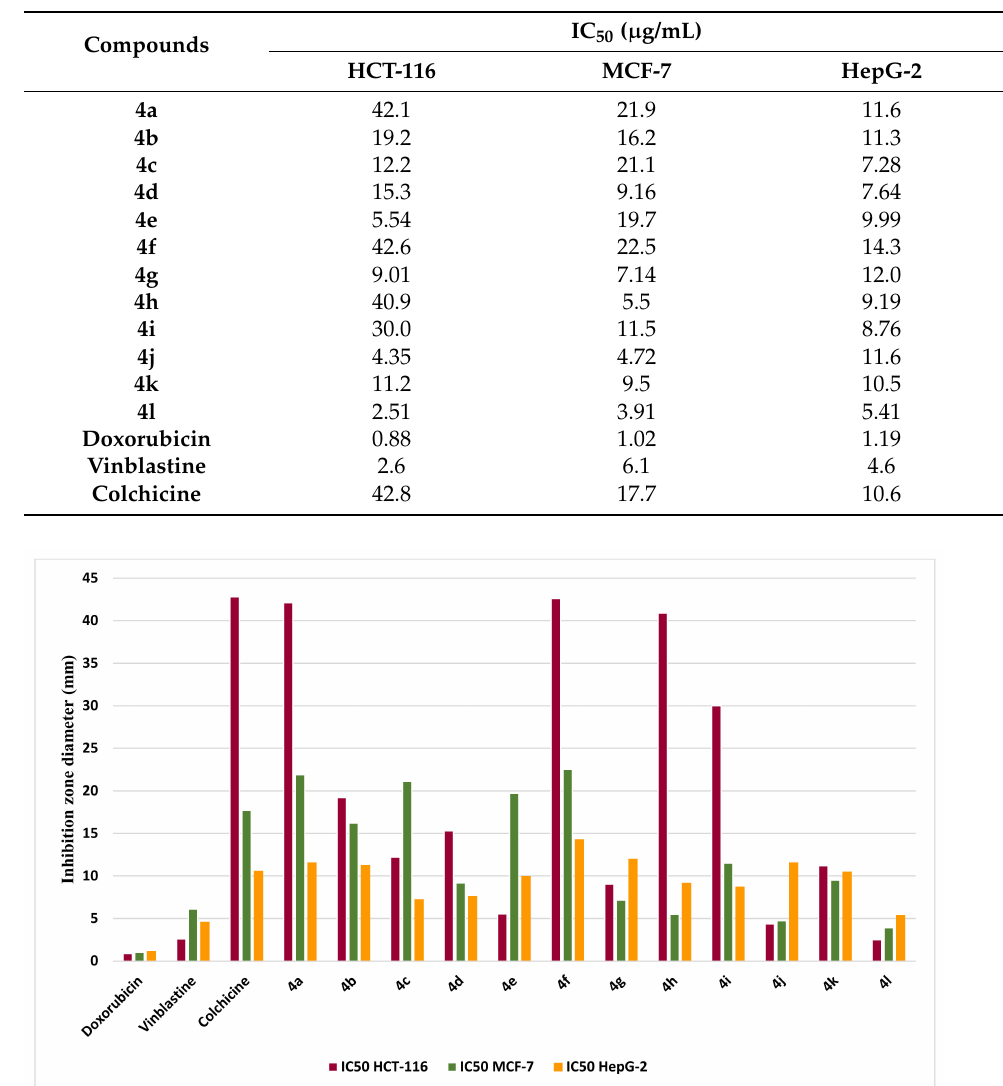
Table 4. Cytotoxicity of chromene derivatives against three different cancer cell lines.